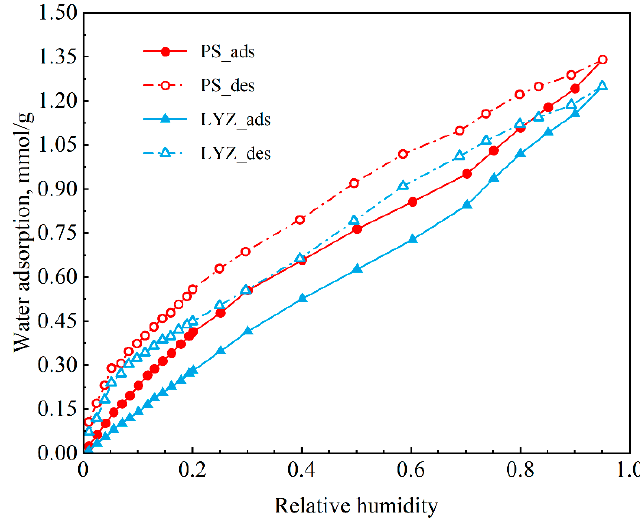
Figure 4. Water vapor ad/desorption isotherms for the two coal samples at 30 °C.